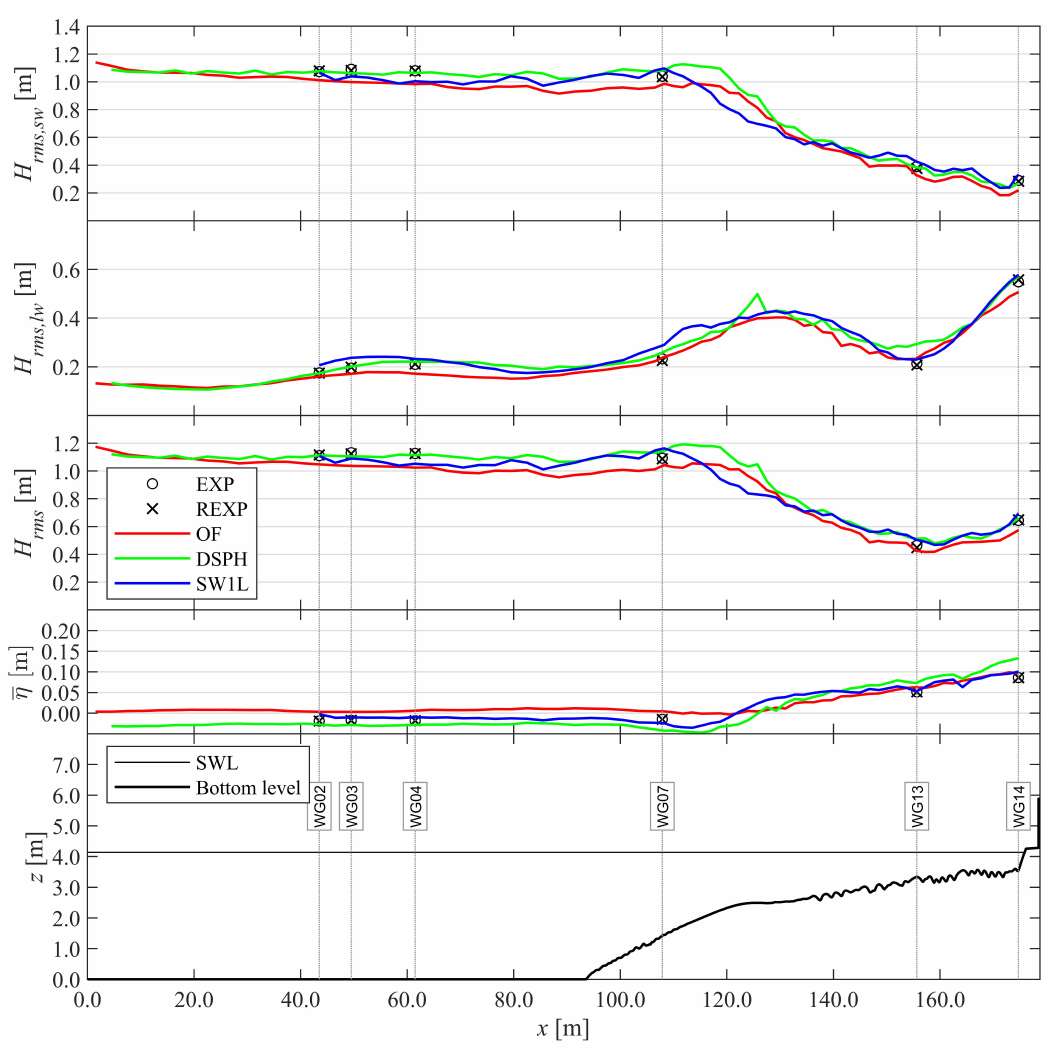
Figure 9. Comparison of the root mean square wave height H rms between each numerical model and the (repeated) experiment up to the toe of the dike. From top to bottom: H rms,sw for the short wave components, H rms,lw for the long wave components, H rms for the total surface elevation, mean surface elevation or wave setup η and an overview of the sensor locations, SWL and bottom profile. Adapted from the work in [3], with permission from the authors,